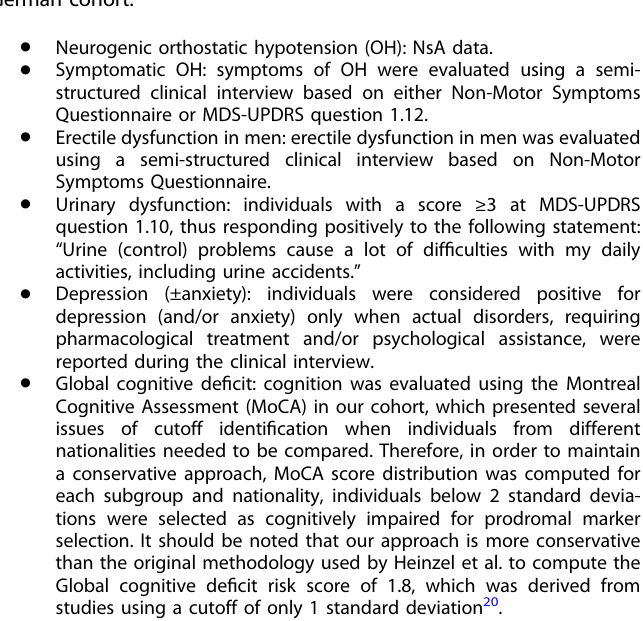
Fig. 2 Study tree of the compared cohorts. Siblings were multicentrically recruited in Italy, Spain and Germany, German siblings were then compared with de novo PD patients and controls from the DeNoPa German